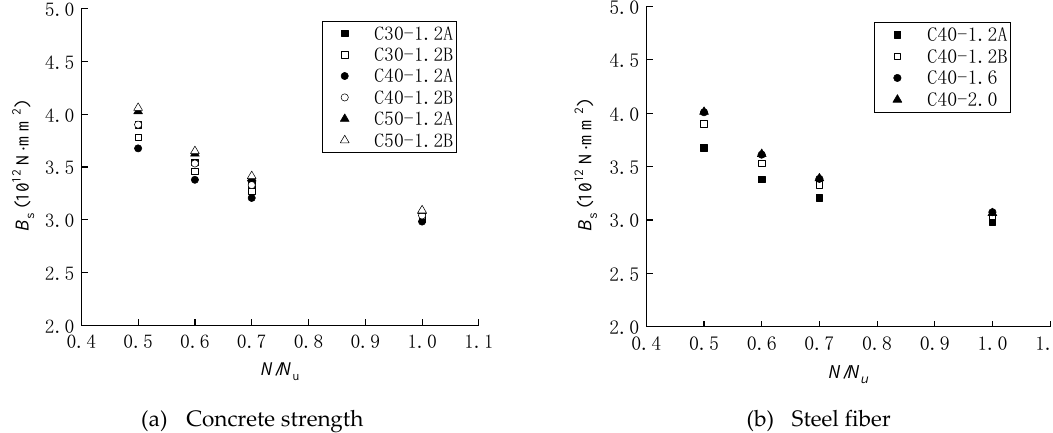
Figure 12. The flexural stiffness: ( a ) Concrete strength; ( b ) Volume fraction of steel fiber.